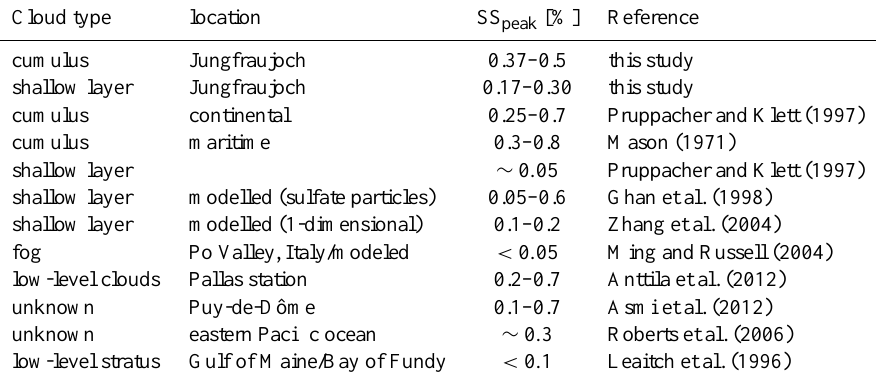
Table 3. Different effective peak supersaturations (SS peak ); or maximum supersaturation for several cloud types and